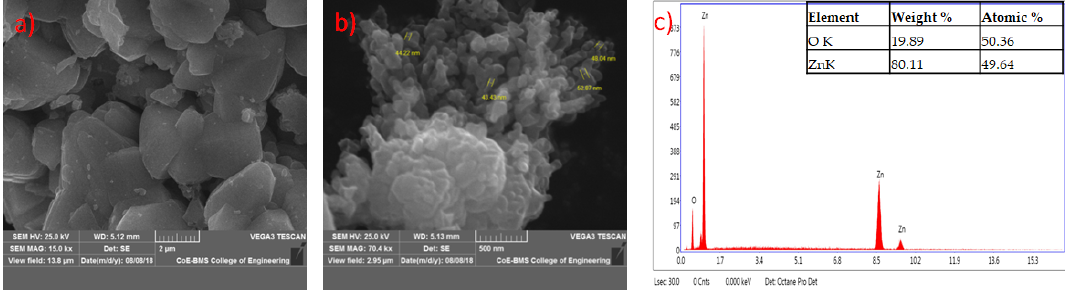
Figure 6. SEM image of zinc oxide nanoparticles synthesized from Trichoderma reesei (PGT5) at lower ( a ) and higher ( b ) magnification; ( c ) represents energy-dispersive X-ray spectroscopy (EDAX) analysis.